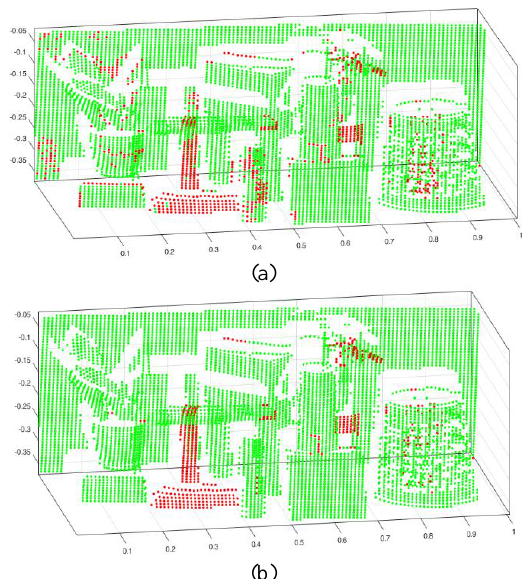
Figure 6. Result based on (a) random forest and (b) CRF. The green and red points indicate the correct and false points,